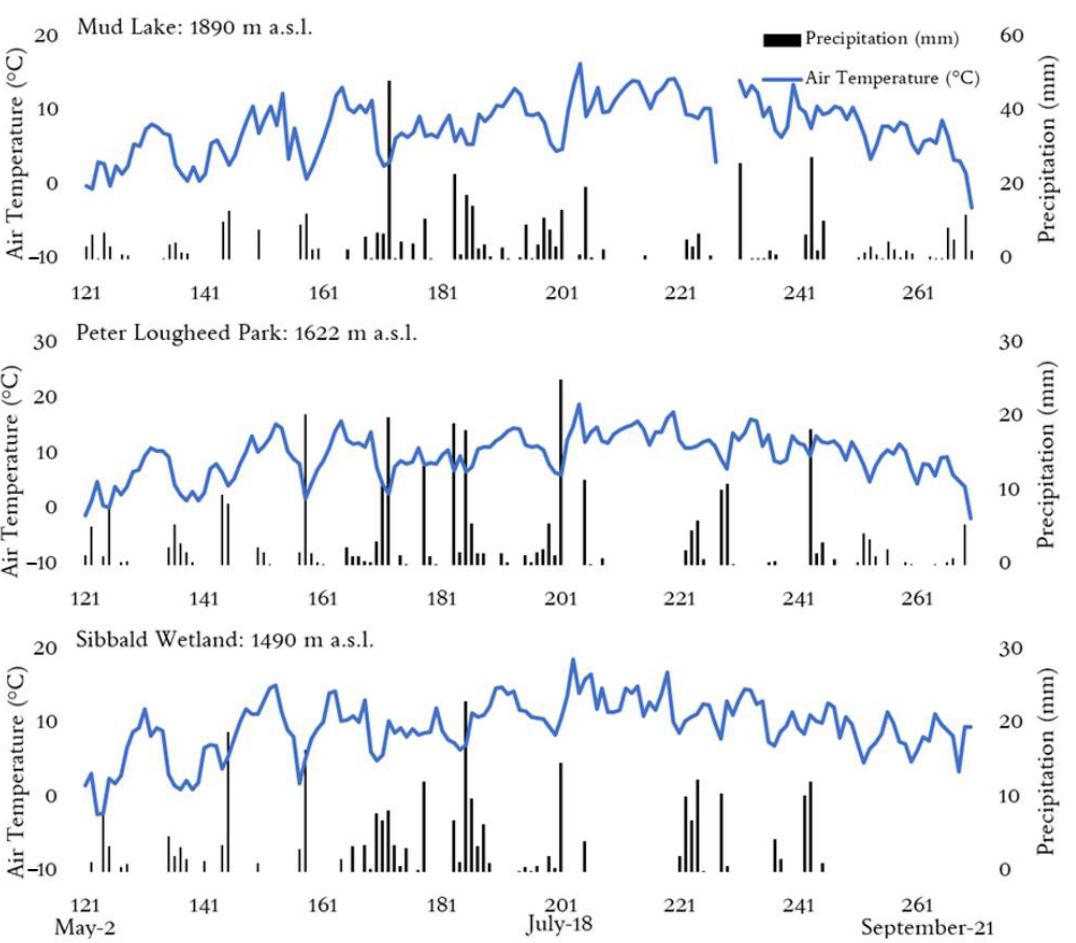
Figure 2. Basic meteorological conditions including precipitation and air temperature from Mud Lake, Peter Lougheed Park, and Sibbald Wetland, Kananaskis, Alberta. Shown are the 2019 daily averages from 1 May to 27 September 2019.